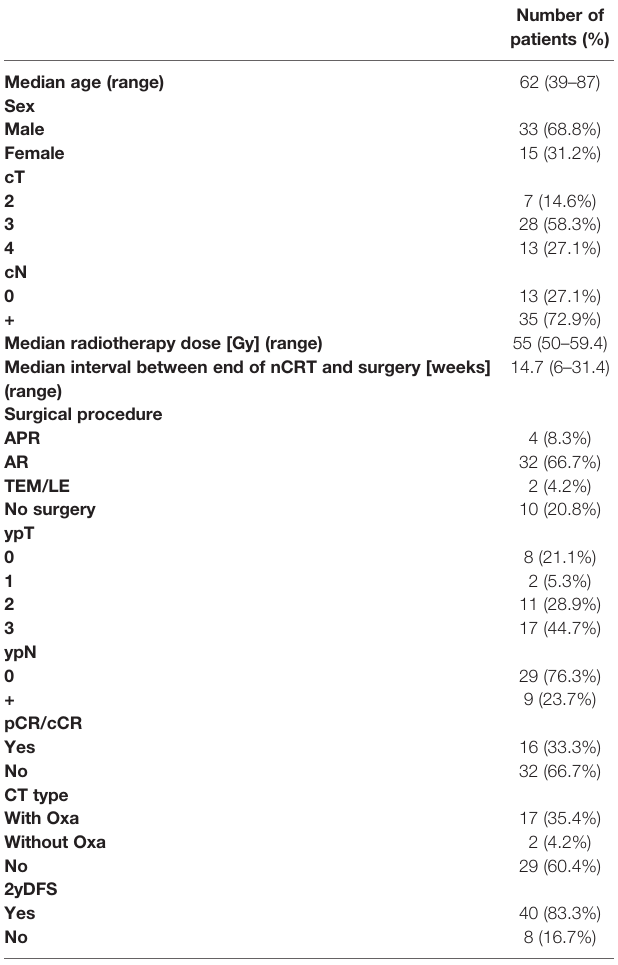
TABLE 1 | Patient